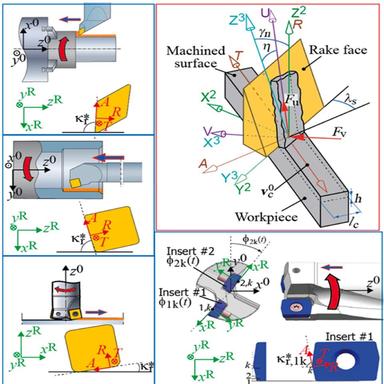
Generalized modeling of cutting mechanics by kinematic transformation from oblique cutting edge to different machining operations .